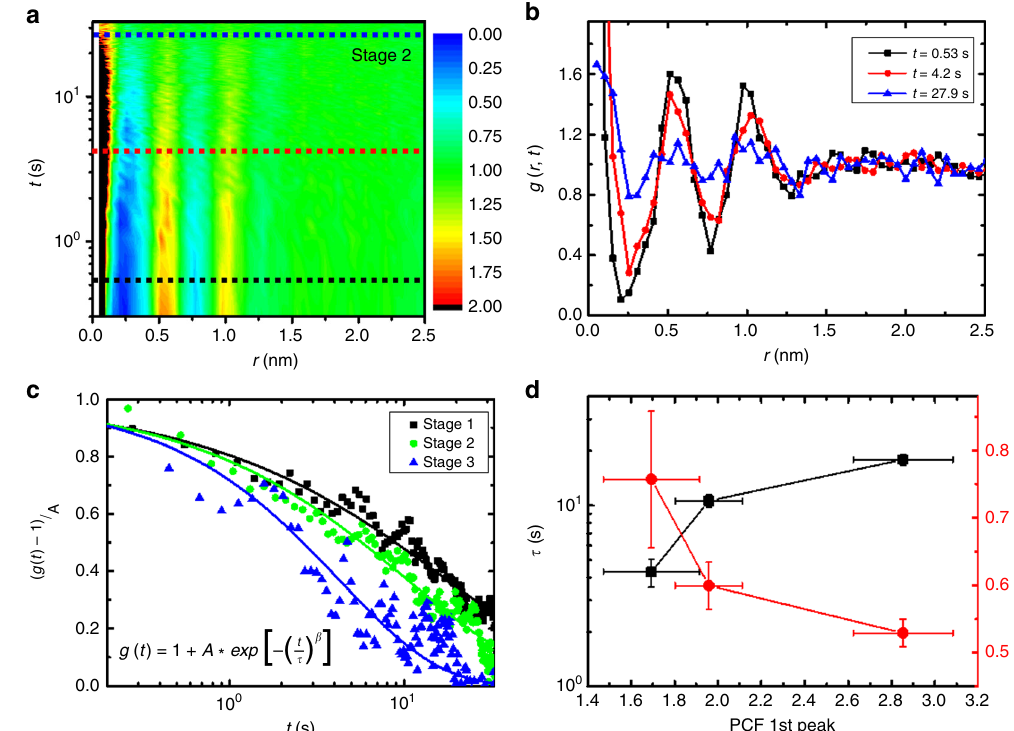
Fig. 4 Time-dependent correlation functions of molecular structures. a van Hove correlation function (vHCF) of C 70 molecular structure. b The evolution of vHCF. The plots are obtained at the dashed lines in a . c Time-evolution of the fi rst peak ( r ~0.53 nm) in vHCF. d Relaxation time τ and decaying parameter β of the molecular structure as a function of structure order. The lateral error bars represent the standard deviations of measurements from 21 image frames. The vertical error bars represent the ranges of τ and β obtained from curve fi tting to the data points in Fig. 4c with a stretched exponential fi tting parameters τ and β . The fi tting functional form does a good